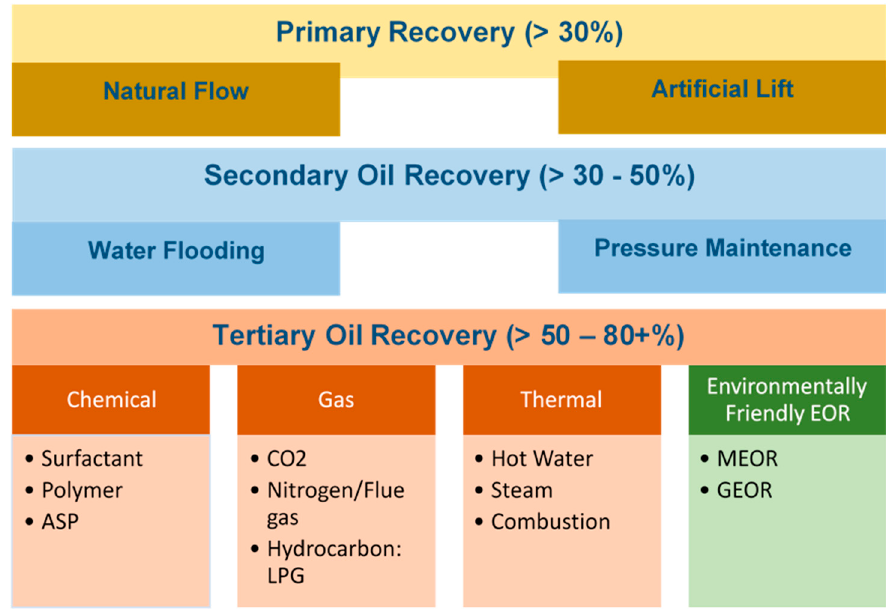
Figure 1. Classification of oil recovery processes.